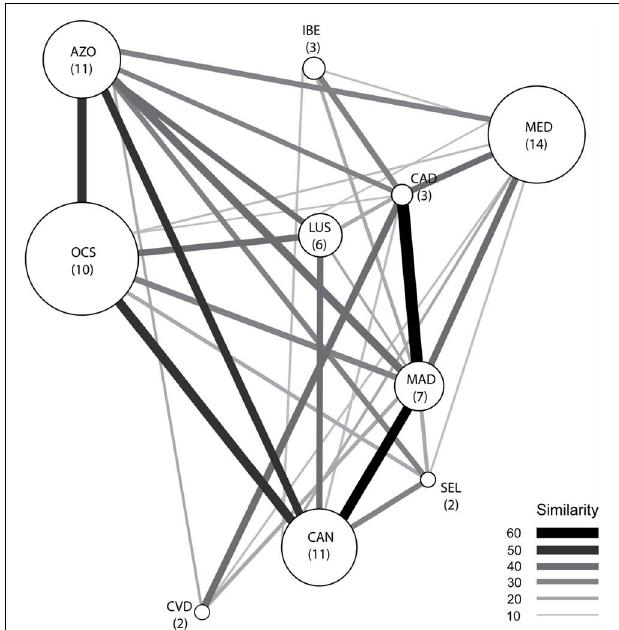
FIGURE 7 | Network of the lithistid faunal similarities across the Northeast Atlantic and Mediterranean Sea. Size of the nodes (areas) is proportional to the number of species in that area (indicated between brackets), whereas thickness and color of the lines between nodes represents Bray–Curtis similarity (%). Areas codes: AZO, Azores; MAD, Madeira; SEL, Selvagens; CAN, Canaries; CVD, Cape Verde; OCS, oceanic seamounts; LUS, Lusitanian seamounts; IBE, Iberian Atlantic margin; CAD, Gulf of Cadiz; MED, Mediterranean